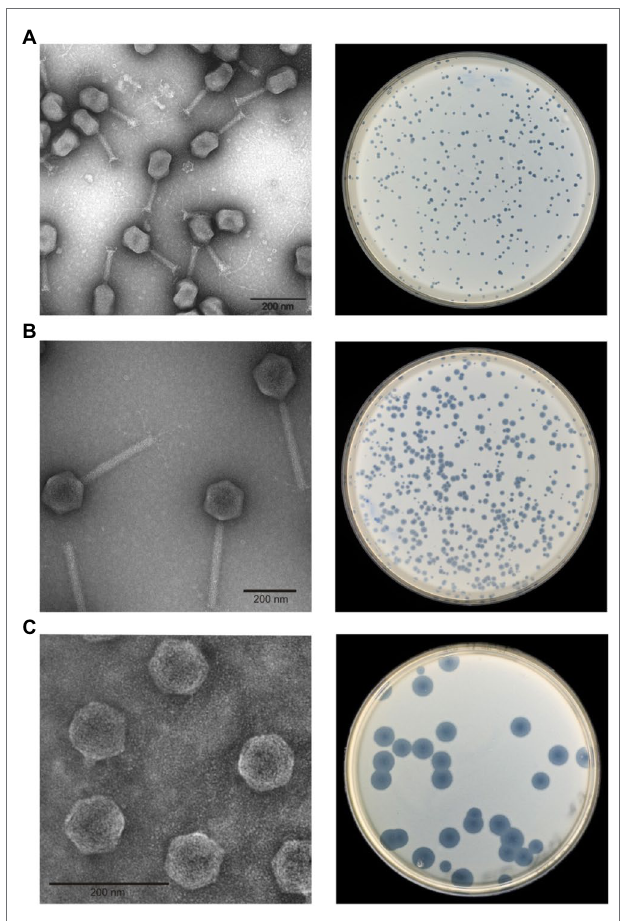
FIGURE 1 | Morphology and plaque formation of Yersinia pseudotuberculosis phages. (A) PYps2T group, (B) PYps23T group, and (C) PYps50T